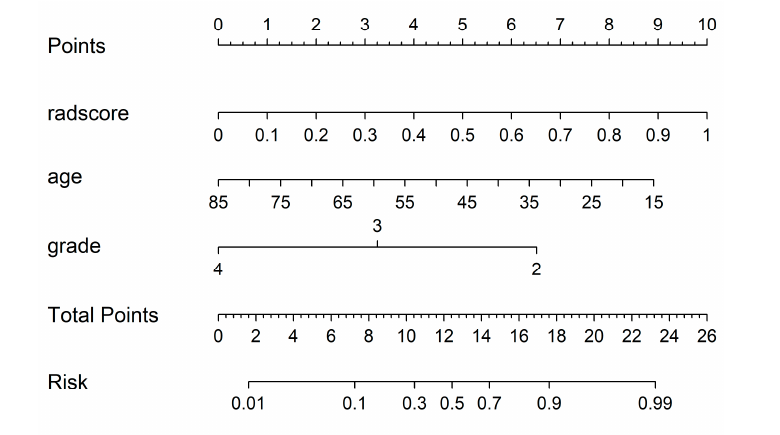
Figure 12. Nomogram of the radiomic–clinical model.